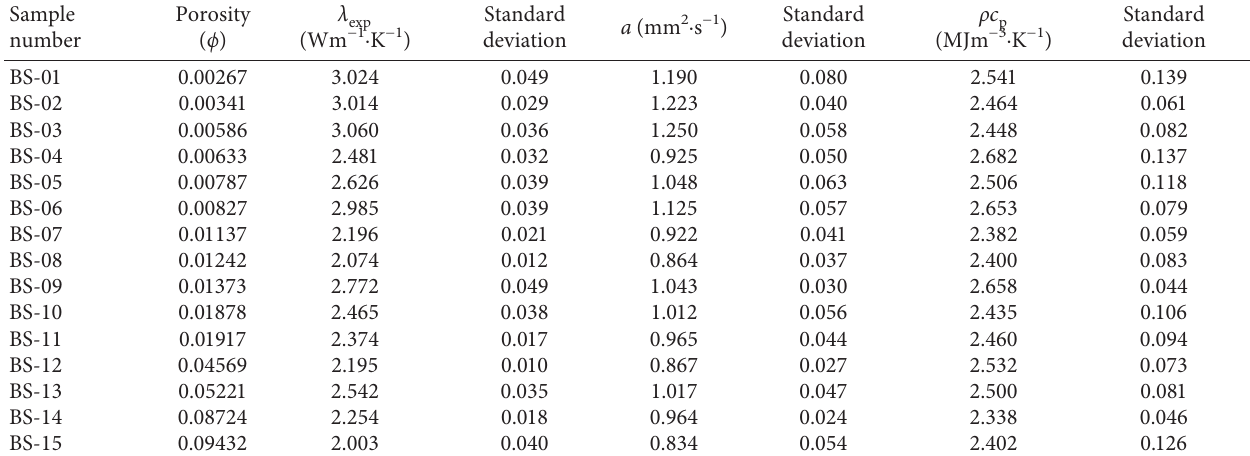
Table 3: Thermal transport properties of basalt rocks along with standard deviations